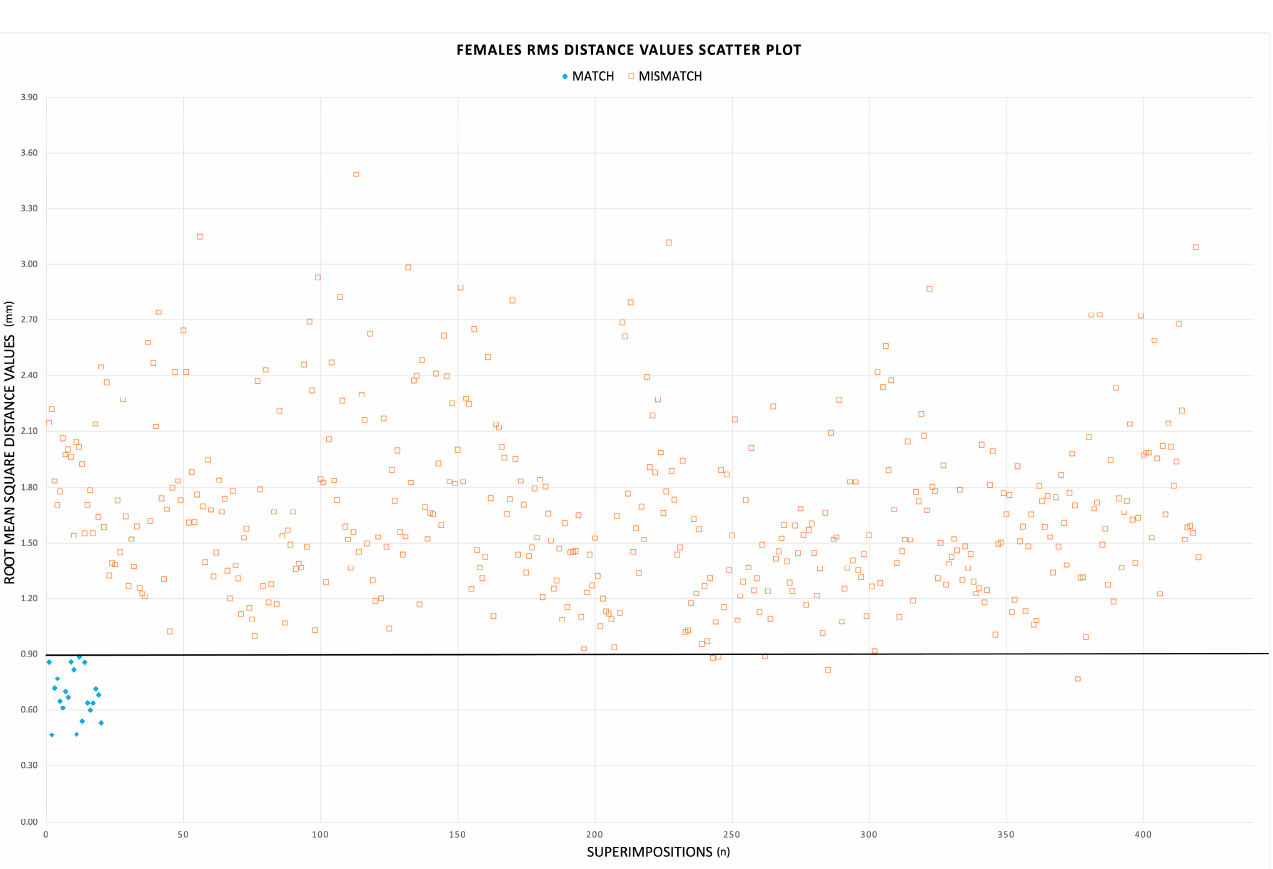
Figure 3. Scatter plot of the RMS distance values for females. The blue diamonds are the 20 RMS distance values of true pair matches, whereas the orange squares are the mismatches. The black line represents the threshold of 0.89 mm.